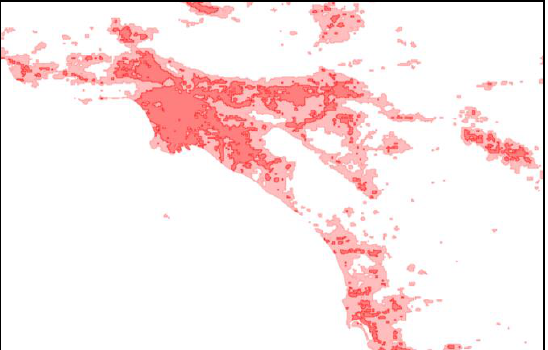
Figure 6. Centers and Peripheries in Southern California 6. Calculating the population of the AHIL by overlapping information on population of the LandScan database developed by the Oak Ridge National Laboratory (2008). This database allows analyzing the population structure of different environments in the urbanized planet, with a close approximation to reality. The figure 7 shows the overlap between contours of intensity 164 or greater with LandScan population in Southern California (green colors =< 50 inhabitants per pixel; orange and red colors >= 250 inhabitants per